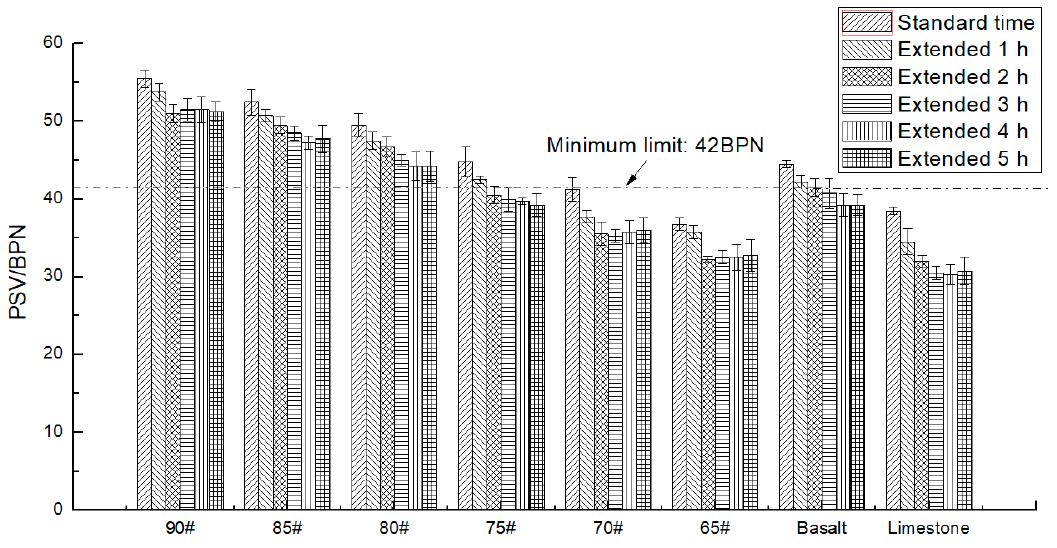
Figure 4. PSV values of aggregates after standard time and extended time. Table 3. PSV values after standard time and extended 5 h.